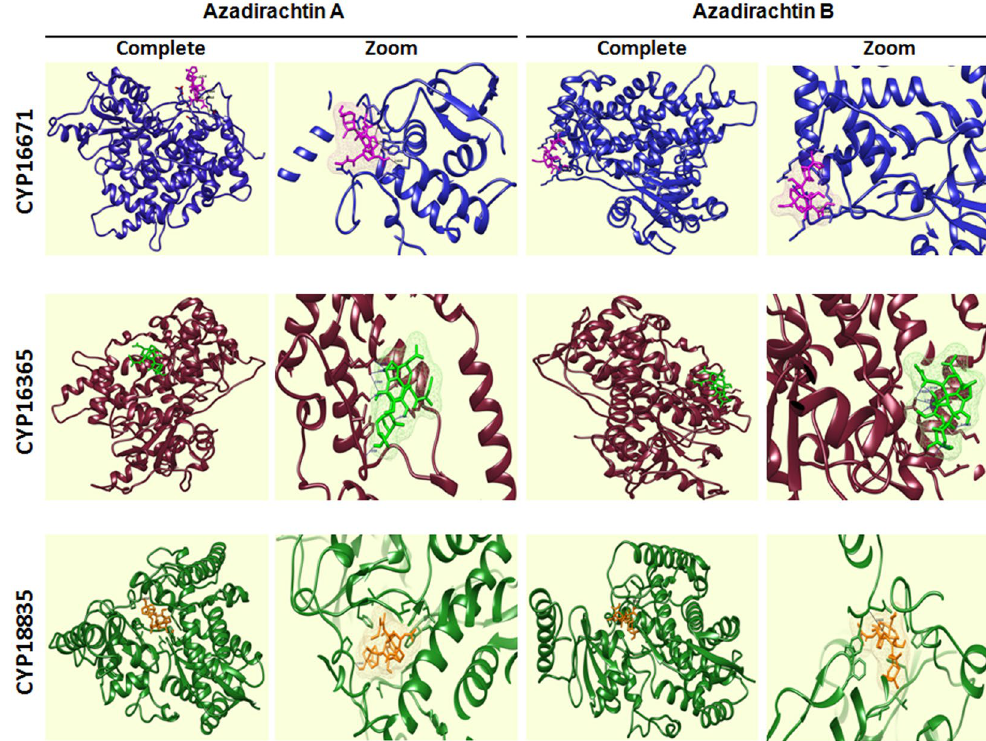
Figure 7. Molecular docking analysis of CYP450 putatively involved in triterpenoid biosynthesis. Interaction of complete protein and docked regions with Azadirachtin A and Azadirachtin B are shown in the figure. Three CYP450s are represented in different colors. Complete block representing the whole protein ligand complex, whereas the zoom blocks are showing the interacting orientation of functional moieties of Azadirachtin A and Azadirachtin B within the cavity of